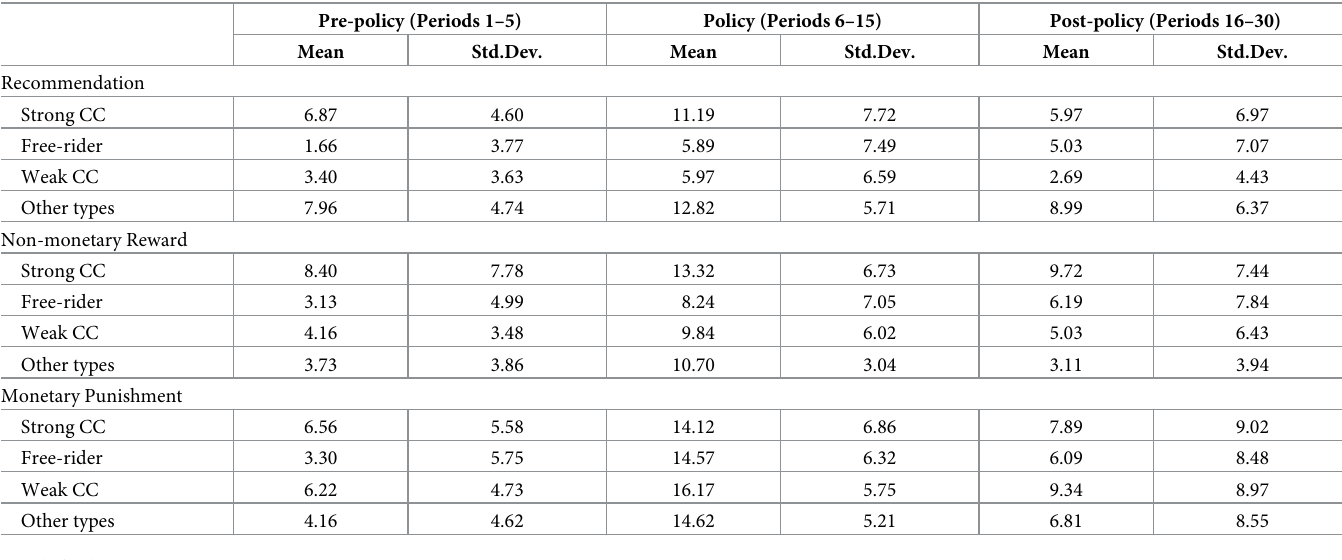
Table 5. Individual average contribution for each